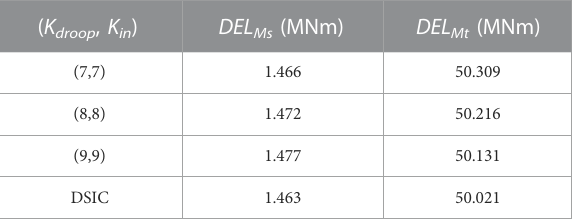
TABLE 5 DELs of shaft torque and tower bending moment under the fi xed gain and DSIC methods.